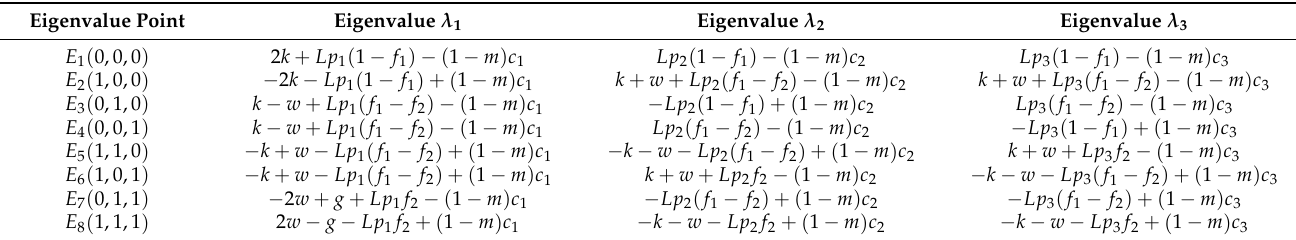
Table 4. Eigenvalues of the Jacobian matrix.